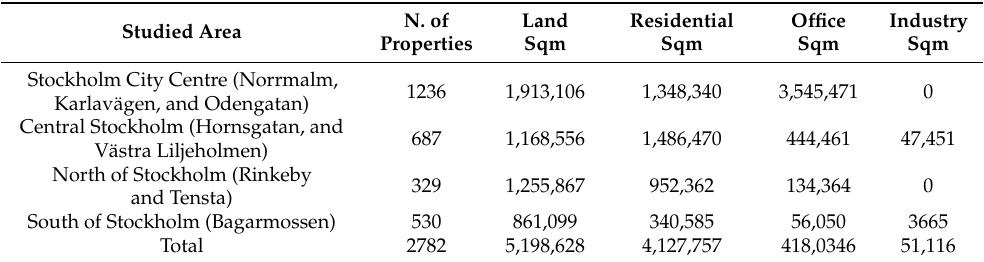
Table 7. Descriptive statistics for areas owned by the Swedish in the studied areas. N. of Studied Area